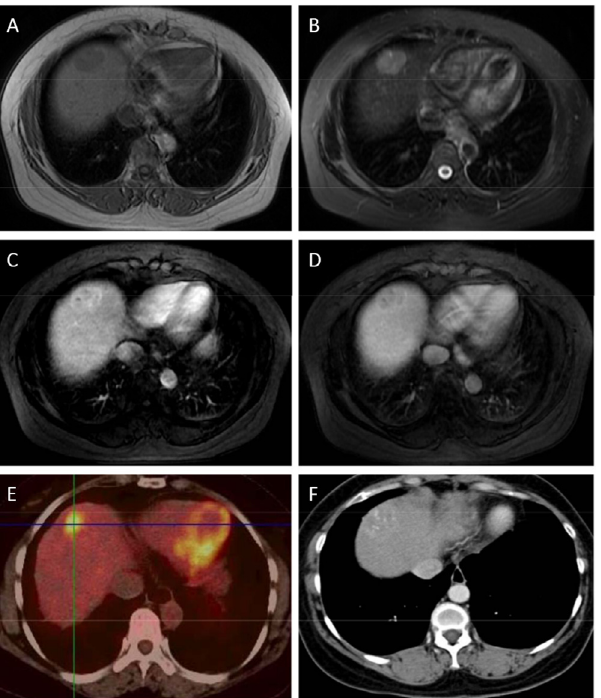
Fig 2. A: A 2.9 * 2.2cm sized round lesion is seen in the segment 8 of the liver which shows low signal intensity on T1-weighted MR image. B: A 2.9 * 2.2cm sized round lesion is seen in the segment 8 of the liver which shows slightly high signal intensity on T2-weighted MR image. C: Late arterial phase of dynamic contrast enhanced scan shows inhomogeneous enhancement in the lesion with obvious enhancement on the border. D: Portal venous phase of dynamic contrast enhanced scan shows the overall enhancement has not washed out. E: PET-CT reviews: increasing abnormal uptake with SUV max 6.8. F: CT scan shows punctate distribution lipiodol deposition inside the lesion after